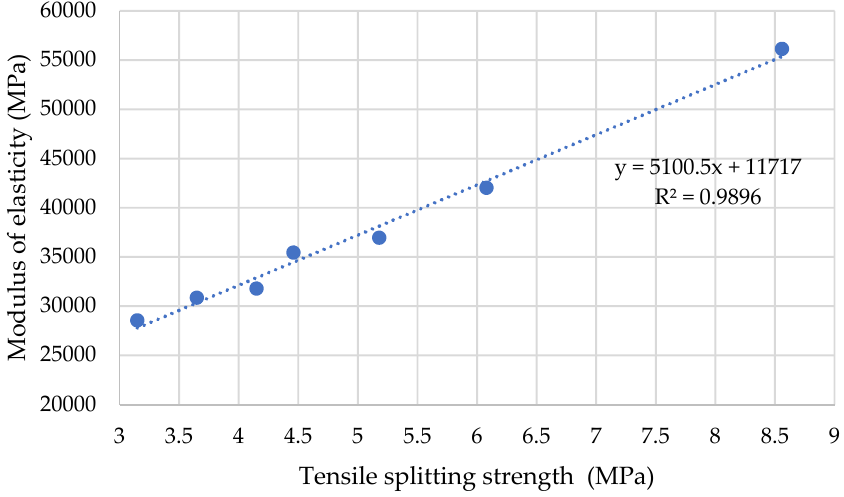
Figure 6. Relationship between tensile splitting strength and modulus of elasticity.